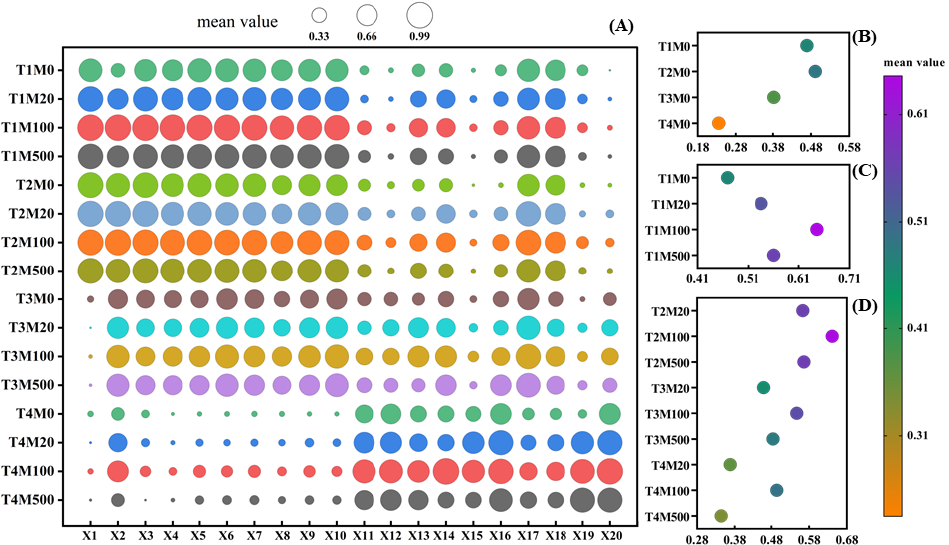
Figure 12. Comprehensive evaluation of rice seed tolerance under the high temperature stress and melatonin single and interactive treatment. ( A ) is the subordinate function value of each index under single and interactive treatment. ( B – D ) are the average subordinate function values of single high temperature treatment, single melatonin treatment, and interactive treatment, respectively. X1: